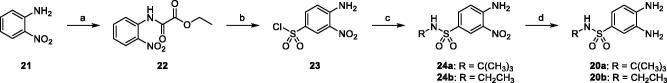
(a) Ethyl chlorooxoacetate, Et2O, r.t. 18 h (98%); (b) ClSO3H,
80 °C, 3 h (77%); c) tert-butylamine or 2M THF solution of
ethylamine, THF, 0 °C to r.t., 18 h (80%); (d) ammonium formate, Pd/C 10%, MeOH,
reflux, 4 h (88–94%).